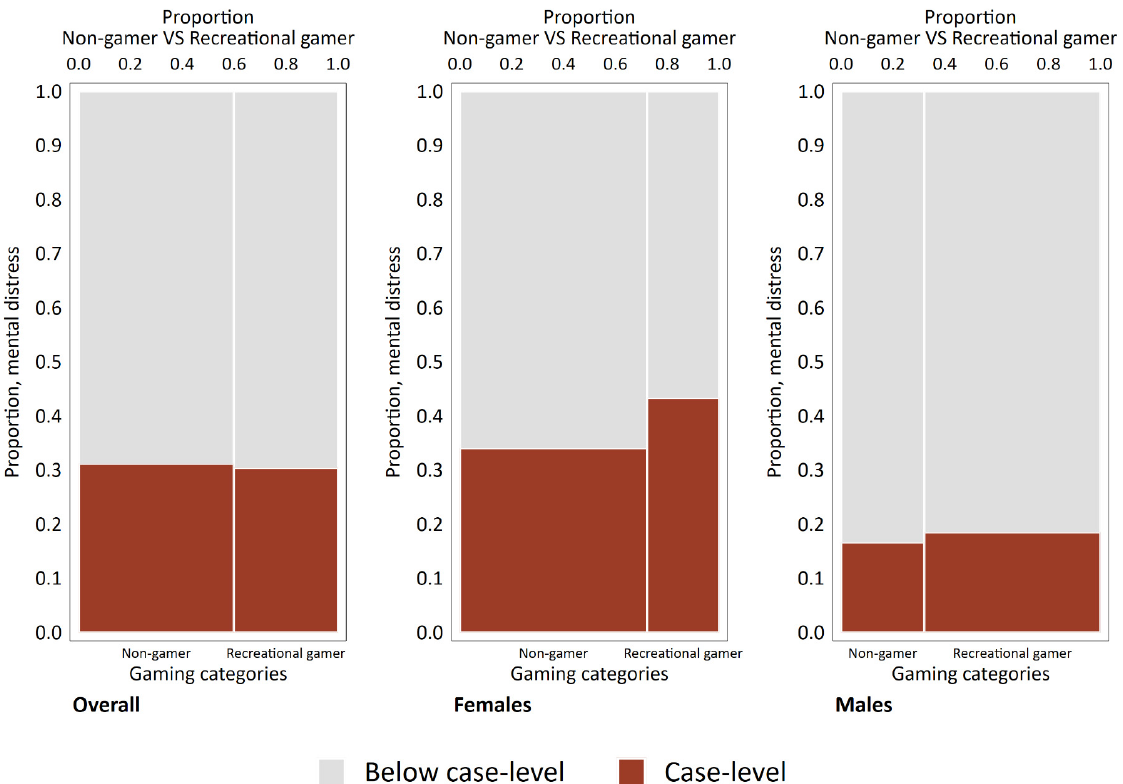
Figure 1. Spineplots showing the distribution of participants in the non-gamer and recreational gamer category both overall and divided by gender across those above and below case-level mental distress.